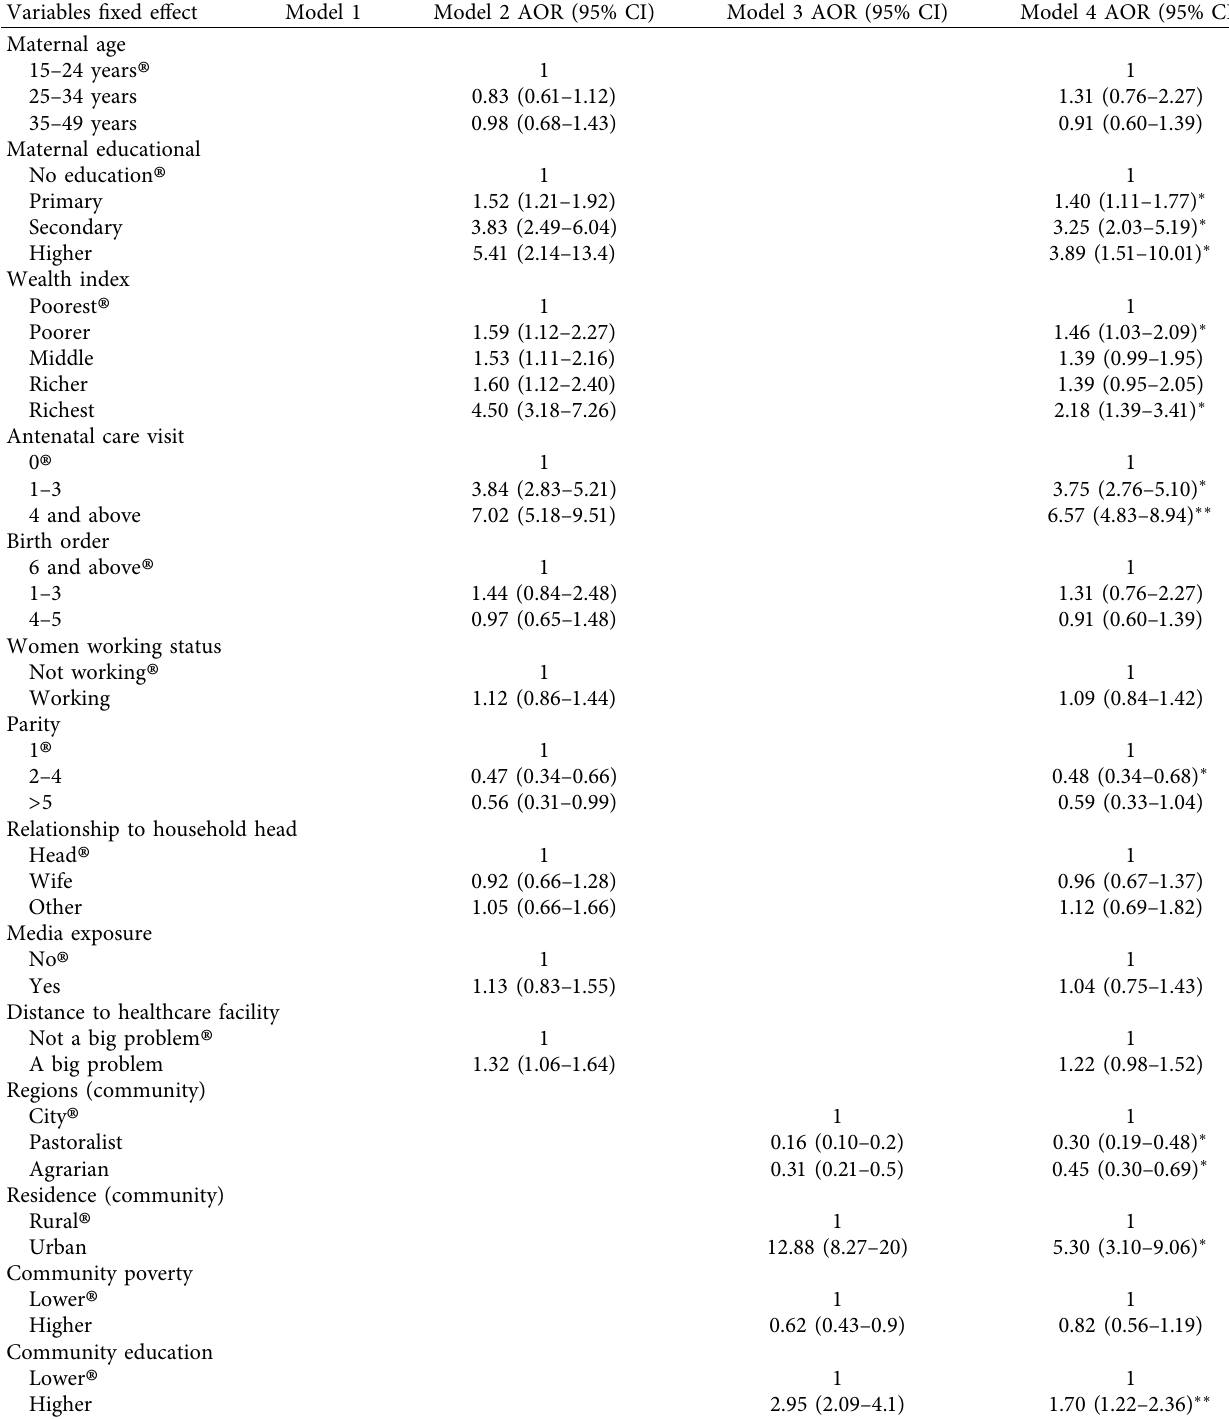
Table 3: Model comparison using parameters (community-level factors, individual-level factors, and null model for 2016 EDHS). Variables fixed